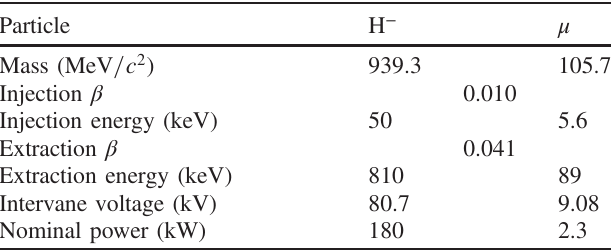
TABLE I. RFQ parameter conversion from H − to μ .